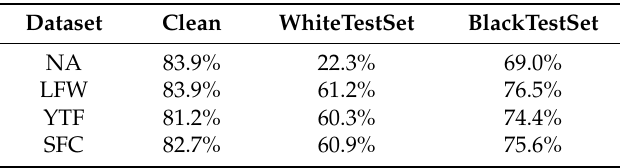
Table 4. Accuracy of model using different datasets.